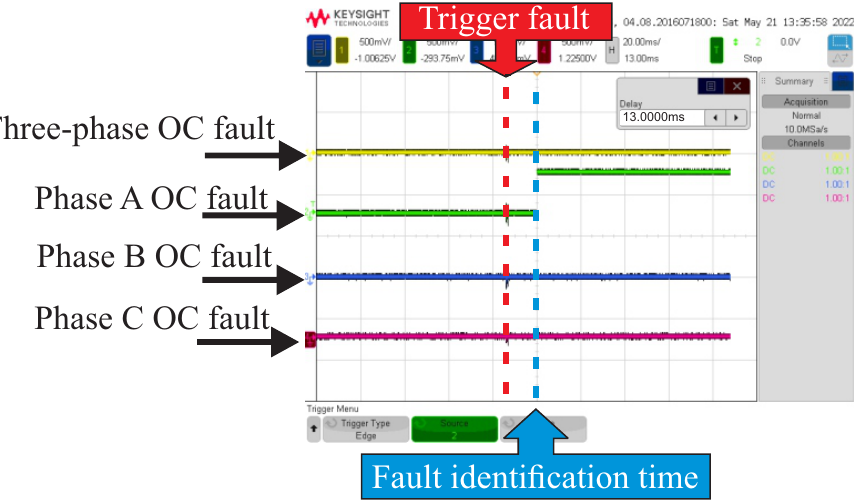
Figure 16. Single-phase open circuit fault identification with 4 × 4 SOM: Phase A; detection time 13 ms.